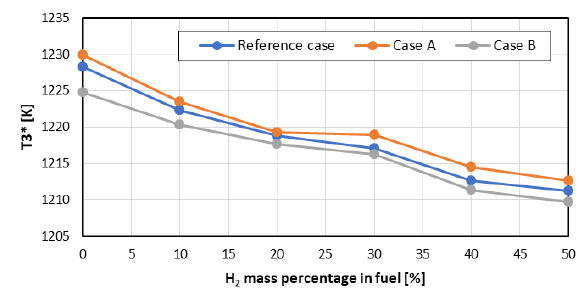
Fig. 13. Averaged exhaust gas total